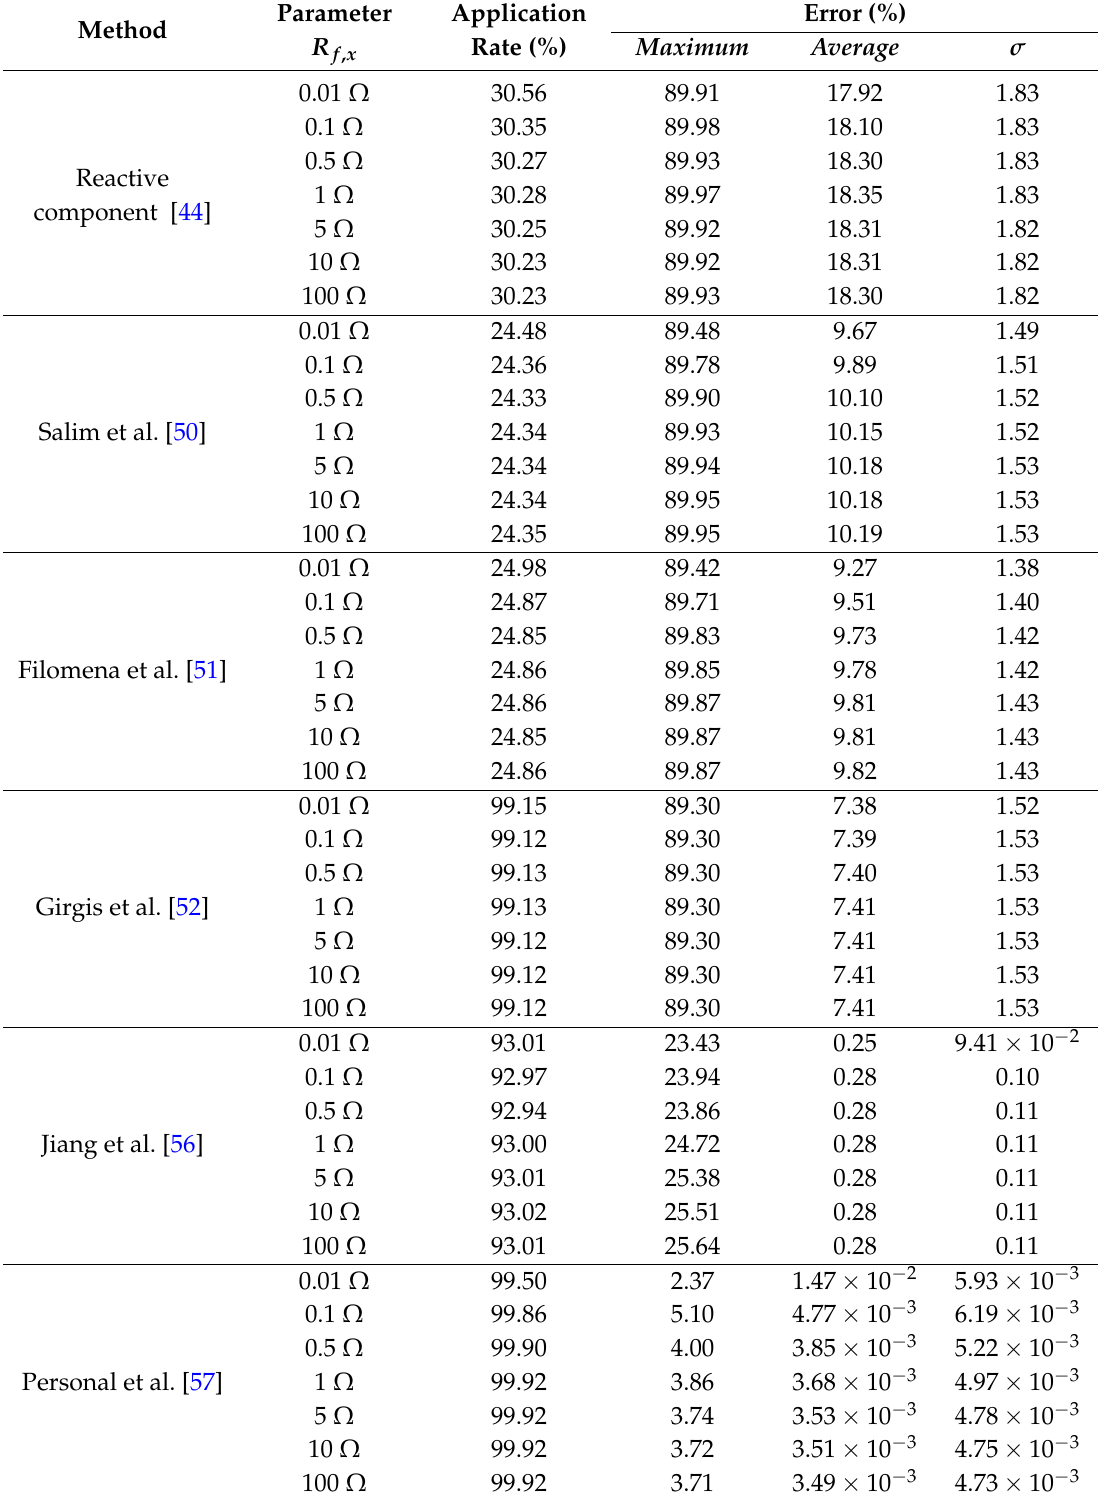
Table A6. Sheath-to-ground resistance